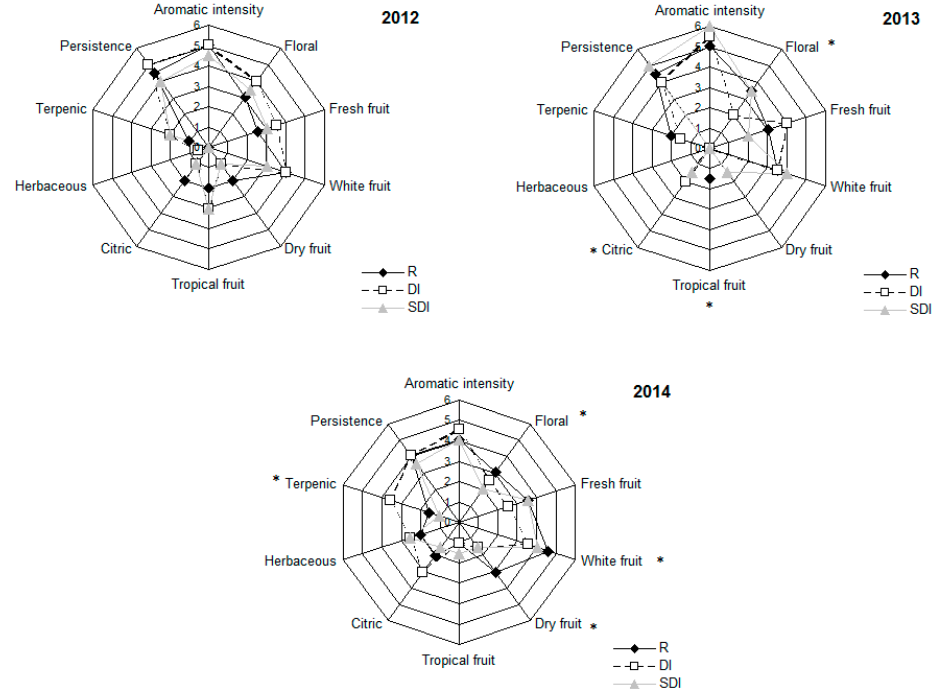
Figure 2. Aroma descriptors for Godello wines (from 2012 to 2014) as a function of rain-fed and irrigation conditions. R = Rain-fed, DI = Drip irrigation, SDI = Subsurface drip irrigation. Asterisks indicate significant differences among treatments according to the Friedman’s test.